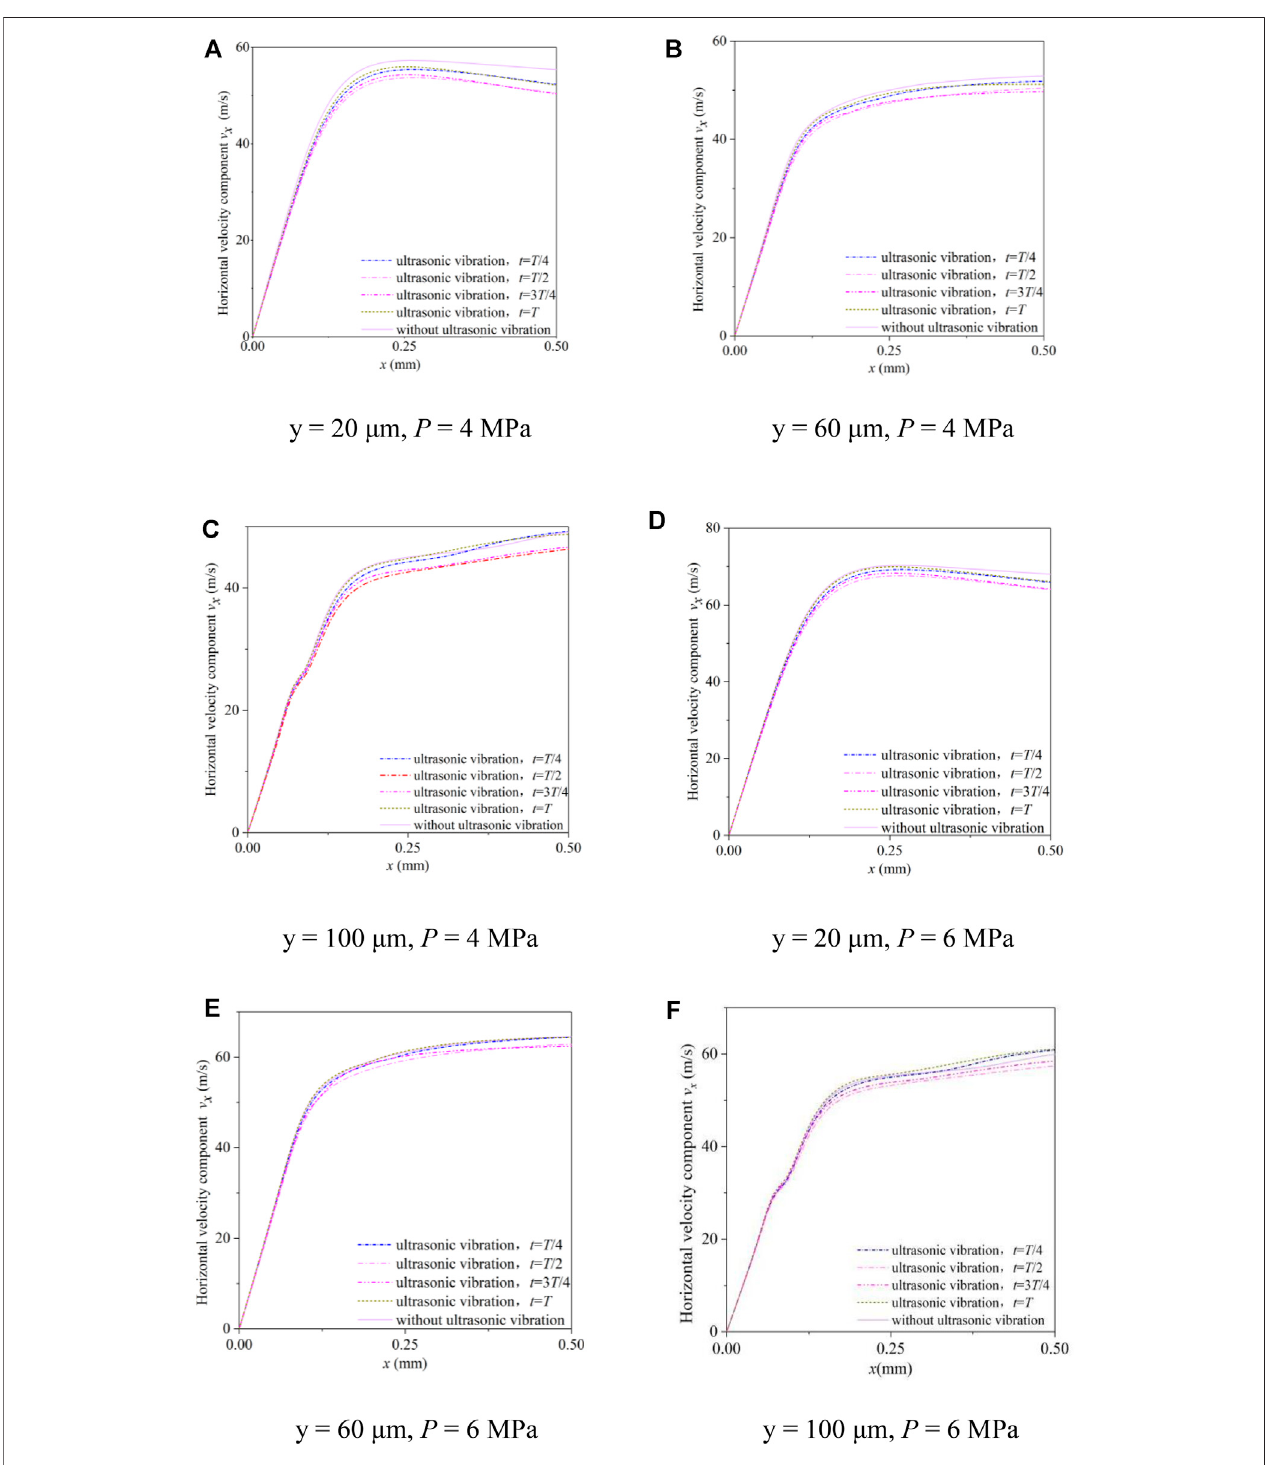
FIGURE4| Thehorizontalcomponentofthejetvelocitynearthesurfaceoftheworkpiece. (A) y =20 μ m, P =4 MPa, (B) y =60 μ m, P =4 MPa, (C) y =100 μ m, P = 4 MPa, (D) y = 20 μ m, P = 6 MPa, (E) y = 60 μ m, P = 6 MPa, (F) y = 100 μ m, P = 6 MPa, (G) y = 20 μ m, P = 8 MPa, (H) y = 60 μ m, P = 8 MPa, and (I) y = 100 μ m, P = 8 MPa.